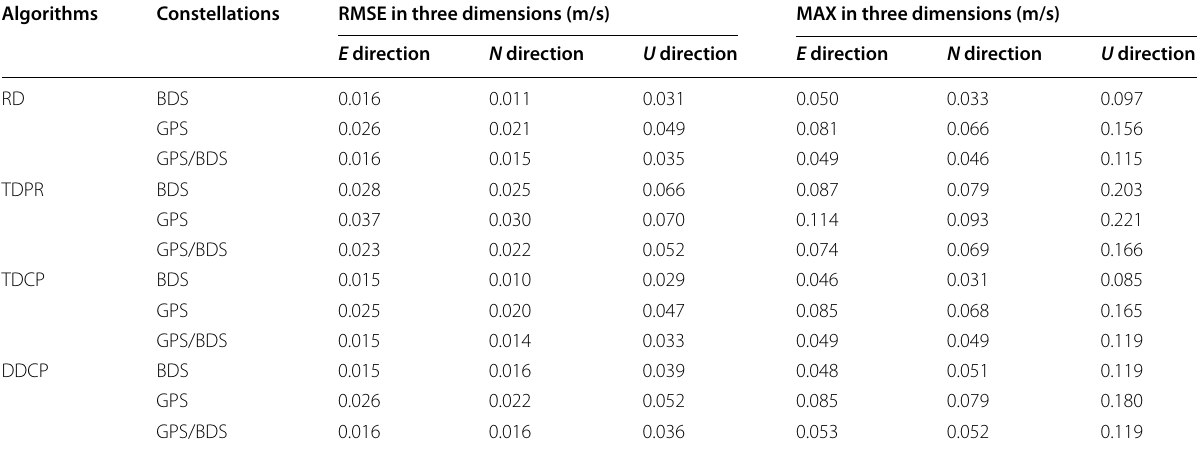
Table 1 Comparisons of velocity accuracies in a static test Algorithms Constellations RMSE in three dimensions